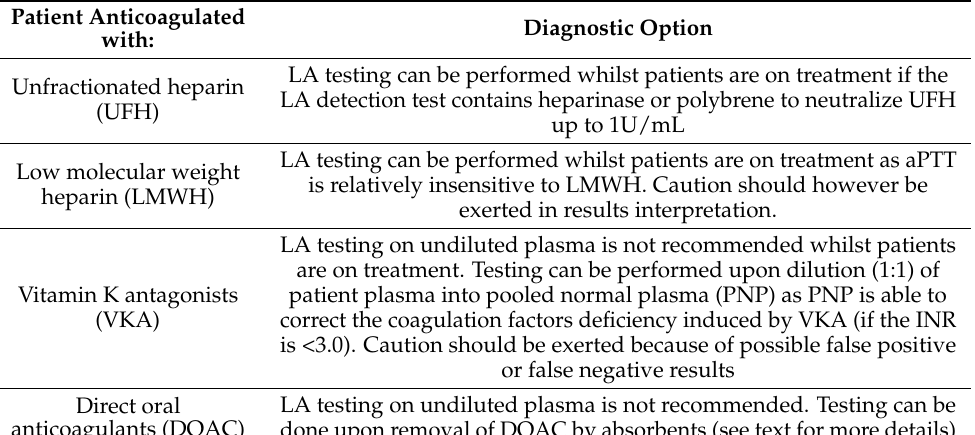
Table 2. Main options to detect lupus anticoagulant (LA) in anticoagulated patients. Patient Anticoagulated